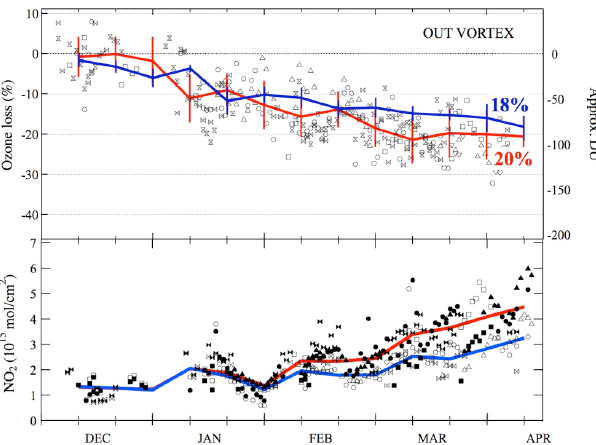
Fig. 5. Top: ECMWF ERA-Interim minimum temperature north Fig. 3. Same as Fig. 2 but outside the vortex. The ozone depletion Figure 5. Top: ECMWF ERA-Interim minimum temperature north of 60°N at 475 K (red), 550 of 60 ◦ N at 475K (red), 550K (blue) and 675K (green) and NAT derived from the difference between SAOZ and passive ozone is (solid lines) and ICE (dotted) threshold temperatures at the same very similar to that simulated by the model in gas-phase chemistry K (blue) and 675 K (green) and NAT (solid lines) and ICE (dotted) threshold temperatures at the levels. Bottom panels: PSC volume between 400–675K, from top only. There is no indication of significant contribution from hetero- to bottom: (i) total volume below T NAT (solid line) and T ICE (grey geneous chlorine activation or export of depleted ozone from the same levels. Bottom panels: PSC volume between 400-675 K, from top to bottom: i) total area); (ii) sunlit (SZA < 93 ◦ ) PSC volume indicative of chlorine ac- vortex. The NO 2 column and its diurnal variation begin to increase tivation; and (iii) integrated sunlit V PSC in early February, one and a half months sooner than in the inside. volume below T (solid line) and T (grey area); ii) sunlit (SZA< 93°) PSC volume NAT ICE indicative of chlorine activation; and iii) integrated sunlit V . PSC